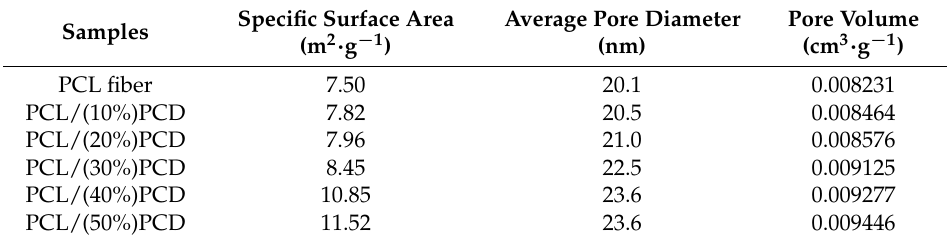
Figure 5. FT-IR spectra of neat PCL fibers and PCL/(n%)PCD ( n = 10, 20, 30, 40, 50) composites. Table 2. Physical data of as-prepared composite fibers.